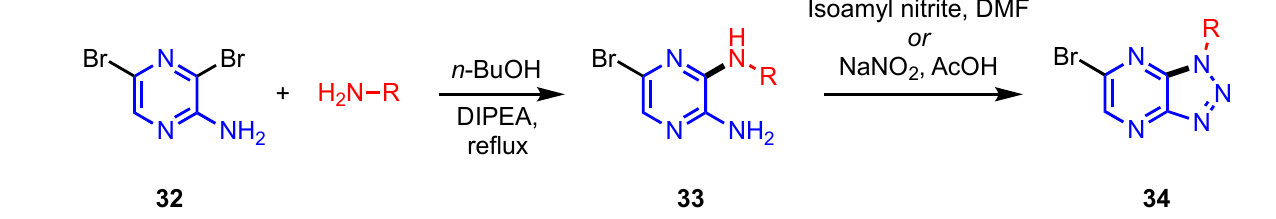
Scheme 6. Amination of 2-amino-3,5-dibromopyrazine 32 to form diaminopyrazine 33 , followed by cyclization to form triazolo[4,5- b ]pyrazine 34 . (R = alkyl or aryl.)